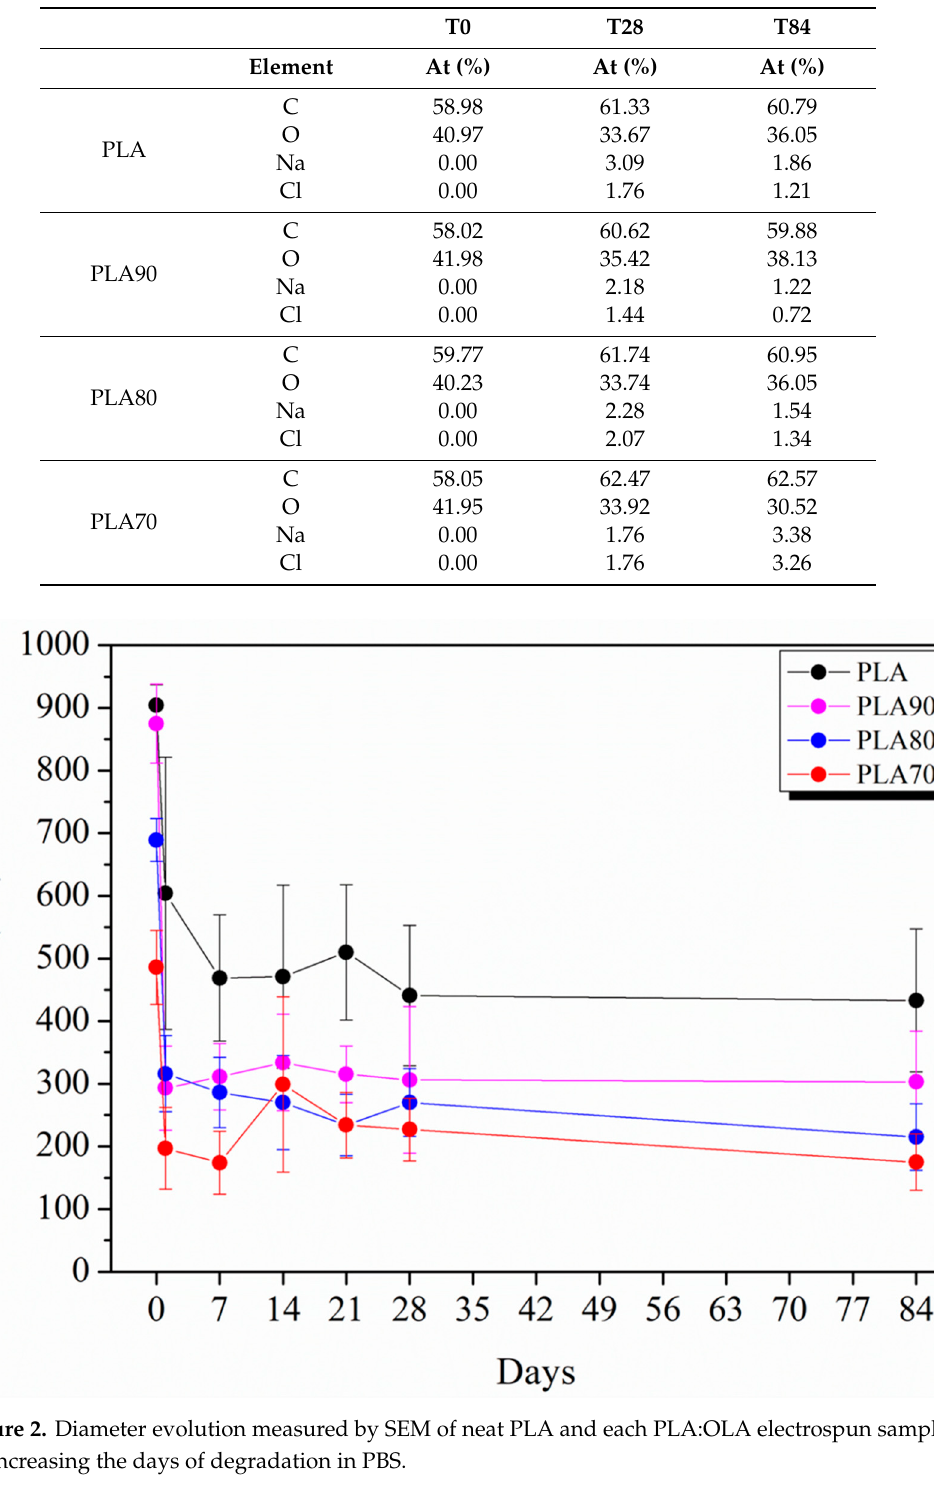
Table 2. Element composition obtained by EDX analysis for neat PLA and each PLA:OLA samples after 0, 28 and 84 days of immersion in PBS: T0, T28 and T84, respectively.